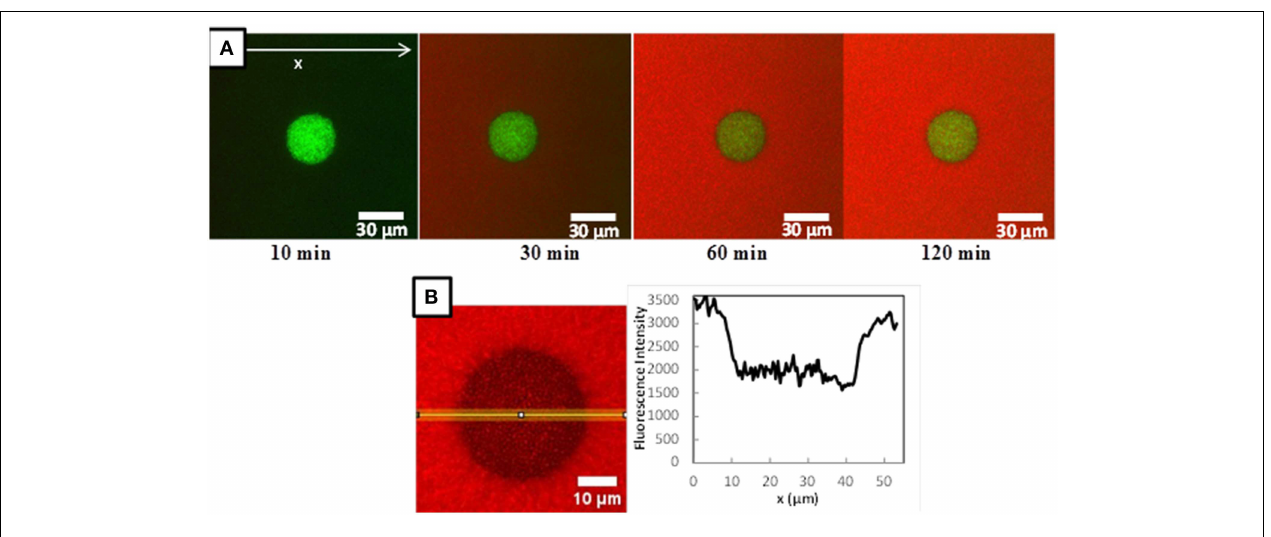
FIGURE 3 | (A) Example of a time-lapse microscopic observations of a Lactococcus lactis LD61 colony immobilized in a model cheese after 15h growth at a temperature of 30 ◦ C during diffusion of a RITC-labeled dextran (here RITC-Dextran 70kDa). L. lactis cells are colored in green, RITC-dextran in red. (B) Focus on the microscopic observation of the